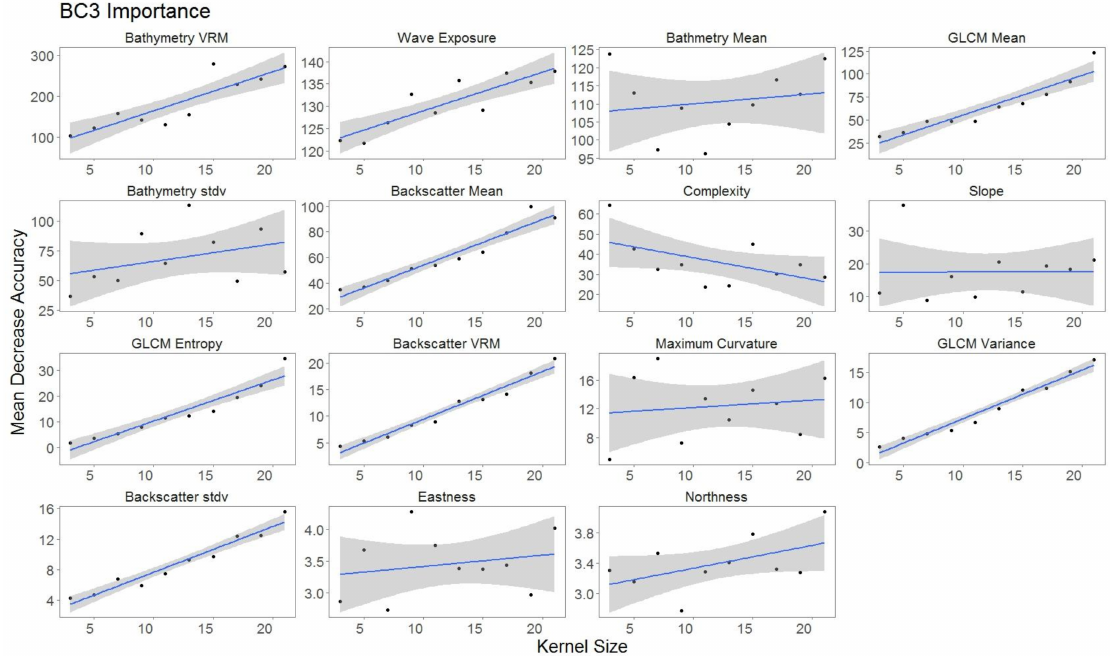
Figure A2. Variable importance BC3 sorted by derivatives in order of importance. GLM trend represented in blue. Gray area represents 95% confidence interval for